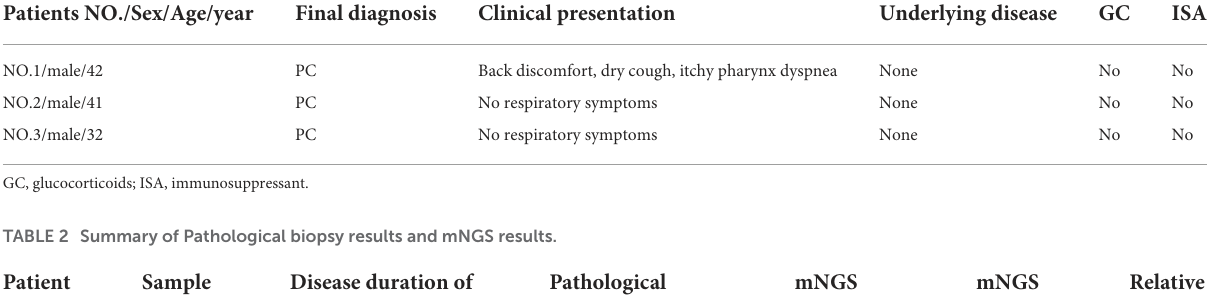
TABLE 1 Clinical characteristics of patients.